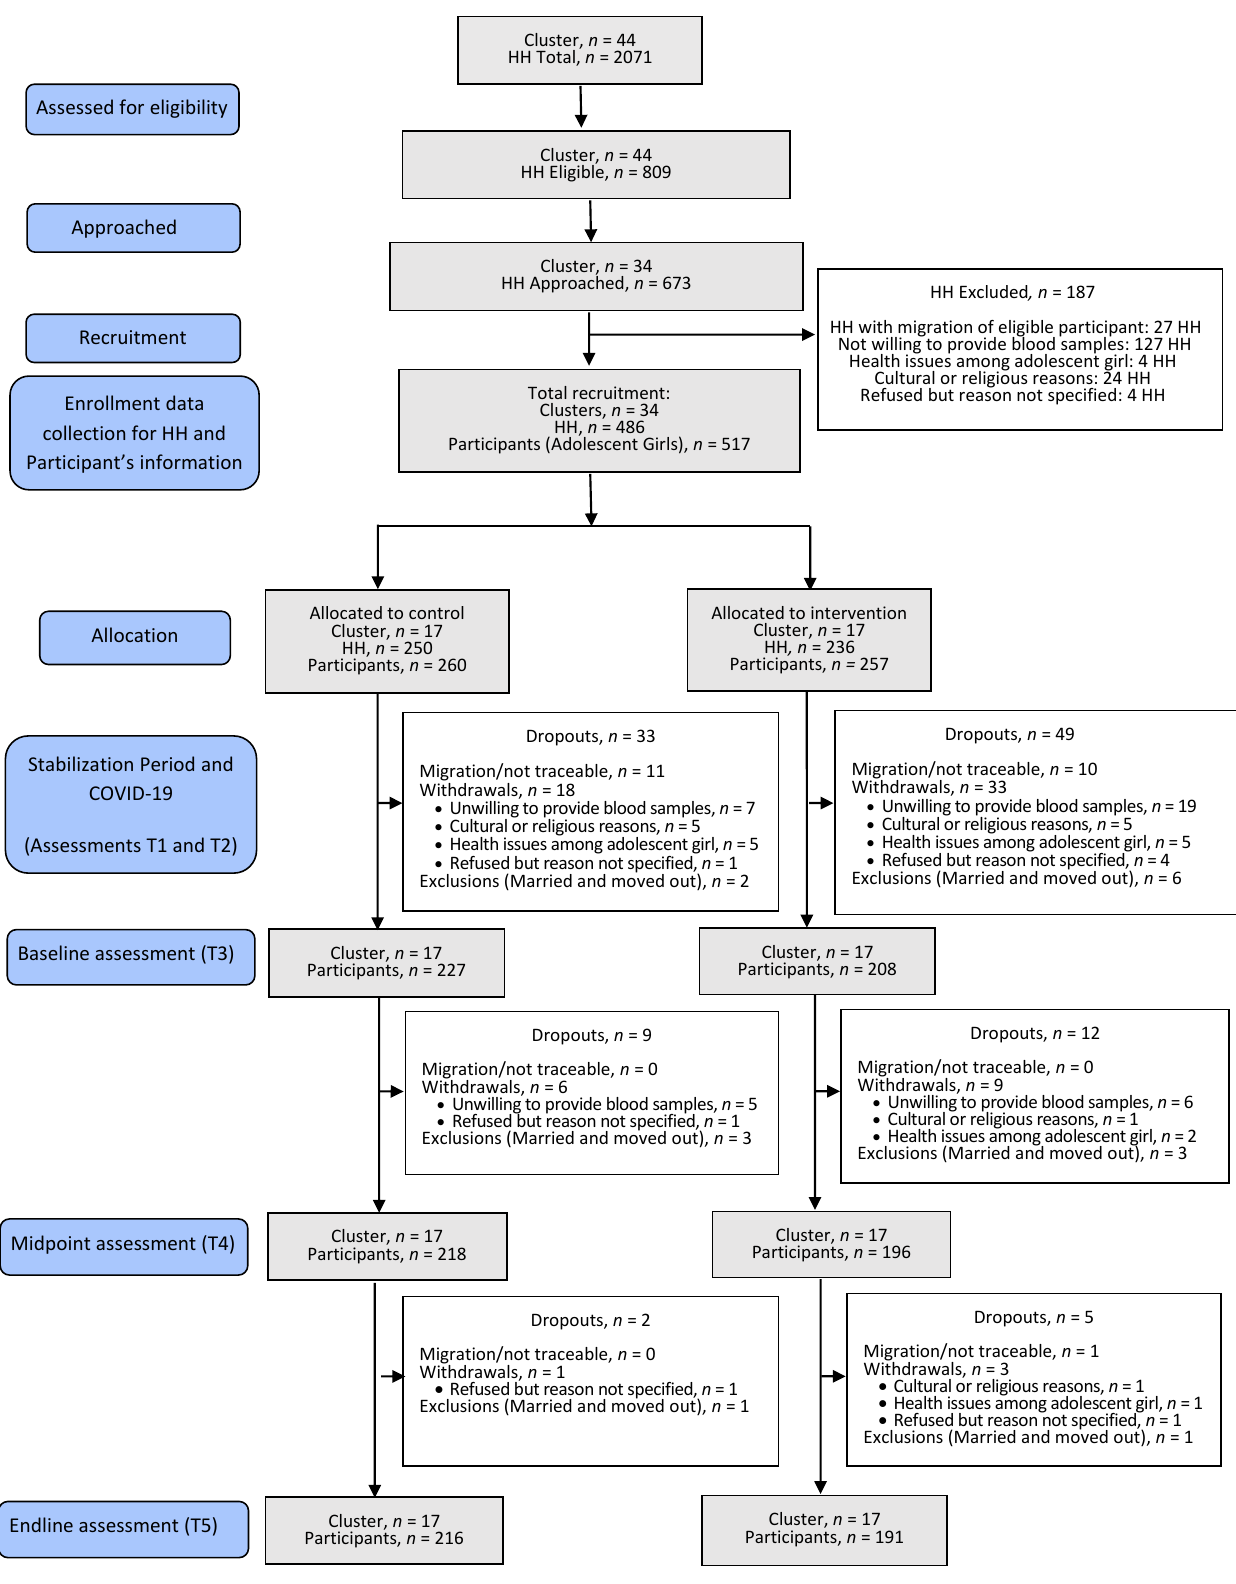
Figure 2. CONSORT flow diagram for the study. CONSORT, Consolidated Standards of Reporting Trials; HH, Households.